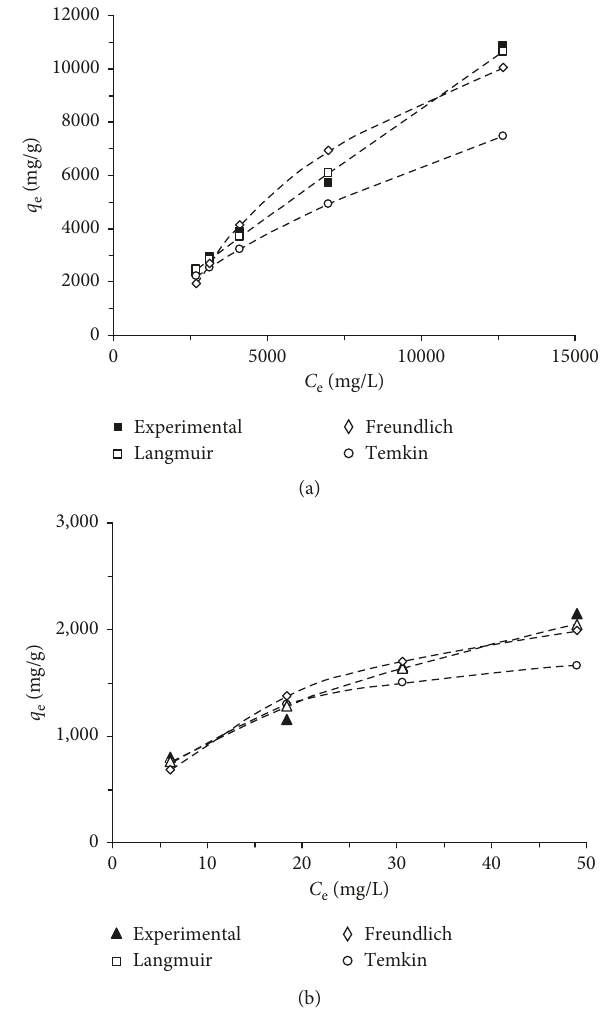
Figure 10: Adsorption of CFW to the modified bagasse under (a) laboratory and (b) pilot